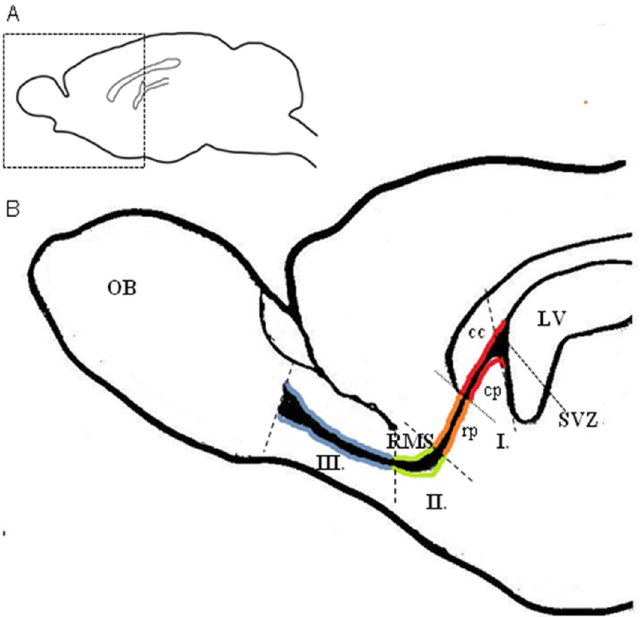
Figure 1. Anatomical regions of the RMS. ( A ) Schematic drawing of a sagittal section of the adult rat brain. ( B ) Schematic drawing of magnification of the boxed area of the picture ( A ) showing the division of the RMS into anatomical regions. The regions are highlighted with different colors. In the caudal to rostral direction, the following can be recognized: the vertical arm (I), which can be subdivided into the caudal part (cp—red) lying under the corpus callosum and the rostral part (rp—orange) leading ventrally; the elbow (II—green) and the horizontal arm (III—blue) leading rostrally toward the OB. LV—lateral ventricle, cc—corpus callosum, OB—olfactory bulb, RMS— rostral migratory stream, SVZ—subventricular